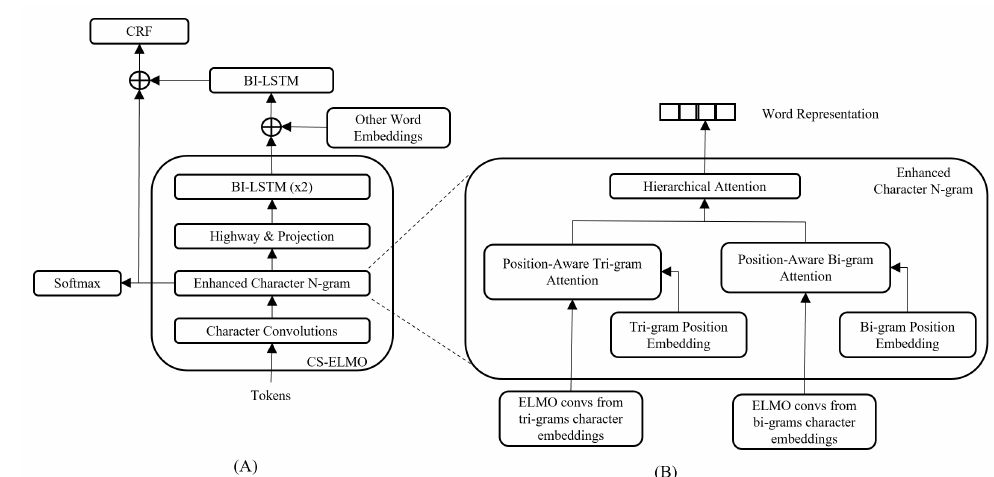
Figure 3. ( A ) The left figure illustrates the overall model architecture. The oversized box describes the components of CS-ELMo. ( B ) The right figure depicts the enhanced character n-gram mechanism inside CS-ELMo